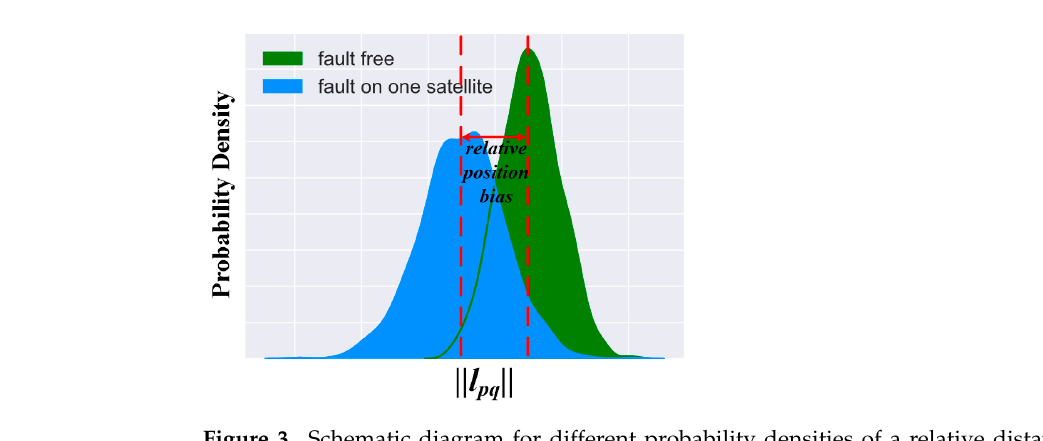
Figure 3. Schematic diagram for different probability densities of a relative distance in case of presence (fault on one satellite) and absence (fault free) of faulty measurements.